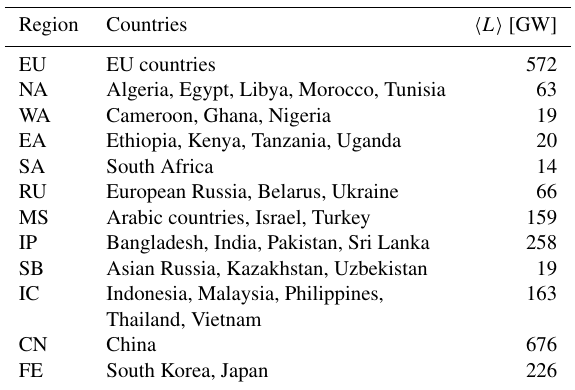
Figure 1. The investigated simplified power system consists of su- per regions connected by long distance transmission lines.